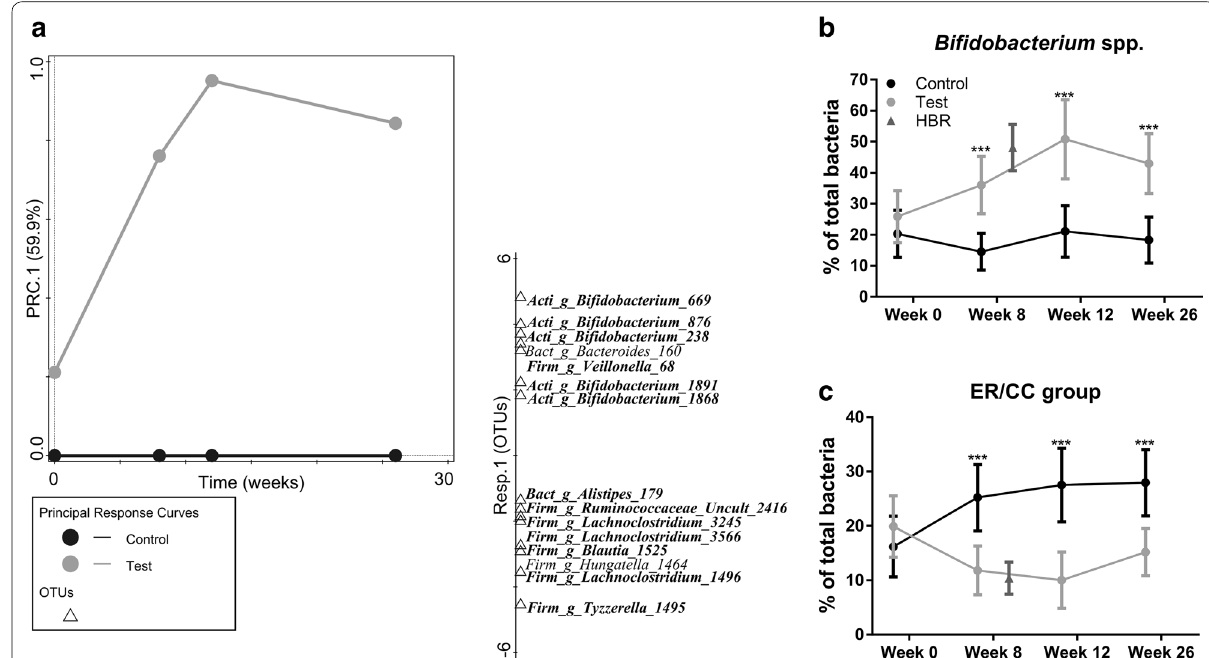
Fig. 4 Principal response curves (PRC) of faecal microbiota composition showing the change in species composition of infants receiving test formula as compared to control ( a ). The diagram shows the first component of the PRC on the vertical axis and time on the horizontal axis with the treatments plotted as single response curves using control as reference with zero PRC values and so its curve lays over the horizontal axis. The top 15 OTUs are plotted on the separate vertical (one‑dimensional) plot based on best fit with the first component of the PRC. In bold the OTUs that were significantly increased (> 0) or decreased (< 0) in Test versus Control at week 8 or at two or more timepoints (week 8/12/26) as confirmed by the two‑part statistics (FDR 0.1). Percentages (means with 95% CI) of bifidobacteria ( b ), and ER/CC group ( c ) quantified by FISH at week 0/8/12/26. ≤ The HBR reference values (age‑matched to week 8) are plotted as well. P‑values are based on ANCOVA comparing Test versus Control with Week 8/12/26 values as outcome, stratification factor and baseline values as covariate and treatment as fixed effect: **P 0.01; ***P 0.001. Taxa names ≤ ≤ are given at the OTU level with unique (but arbitrary) numbers as identifiers, genus level (“_g_”), family level (“_f_”): Bact bacteroidaceae, Bifi bifidobacteriaceae, Lach lachnospiraceae, Rumi ruminococcaceae, Veil veillonellaceae; and phylum level: Acti actinobacteria, Bact bacteroidetes,